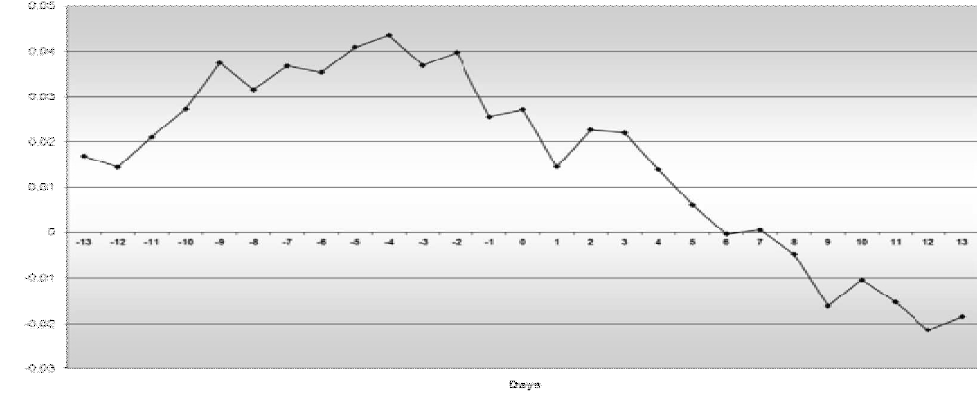
Fig. 8. Cumulated abnormal returns in the market model (reverse stock